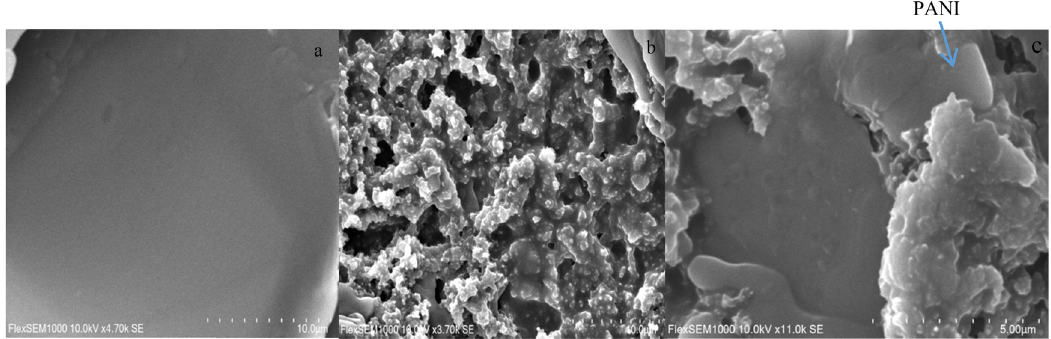
Figure 3: SEM image of SWPU/PANI composites: ( a ) SWPU base fi lm surface image, ( b ) surface diagram of the PANI electrode, and ( c ) base membrane and PANI composite cross